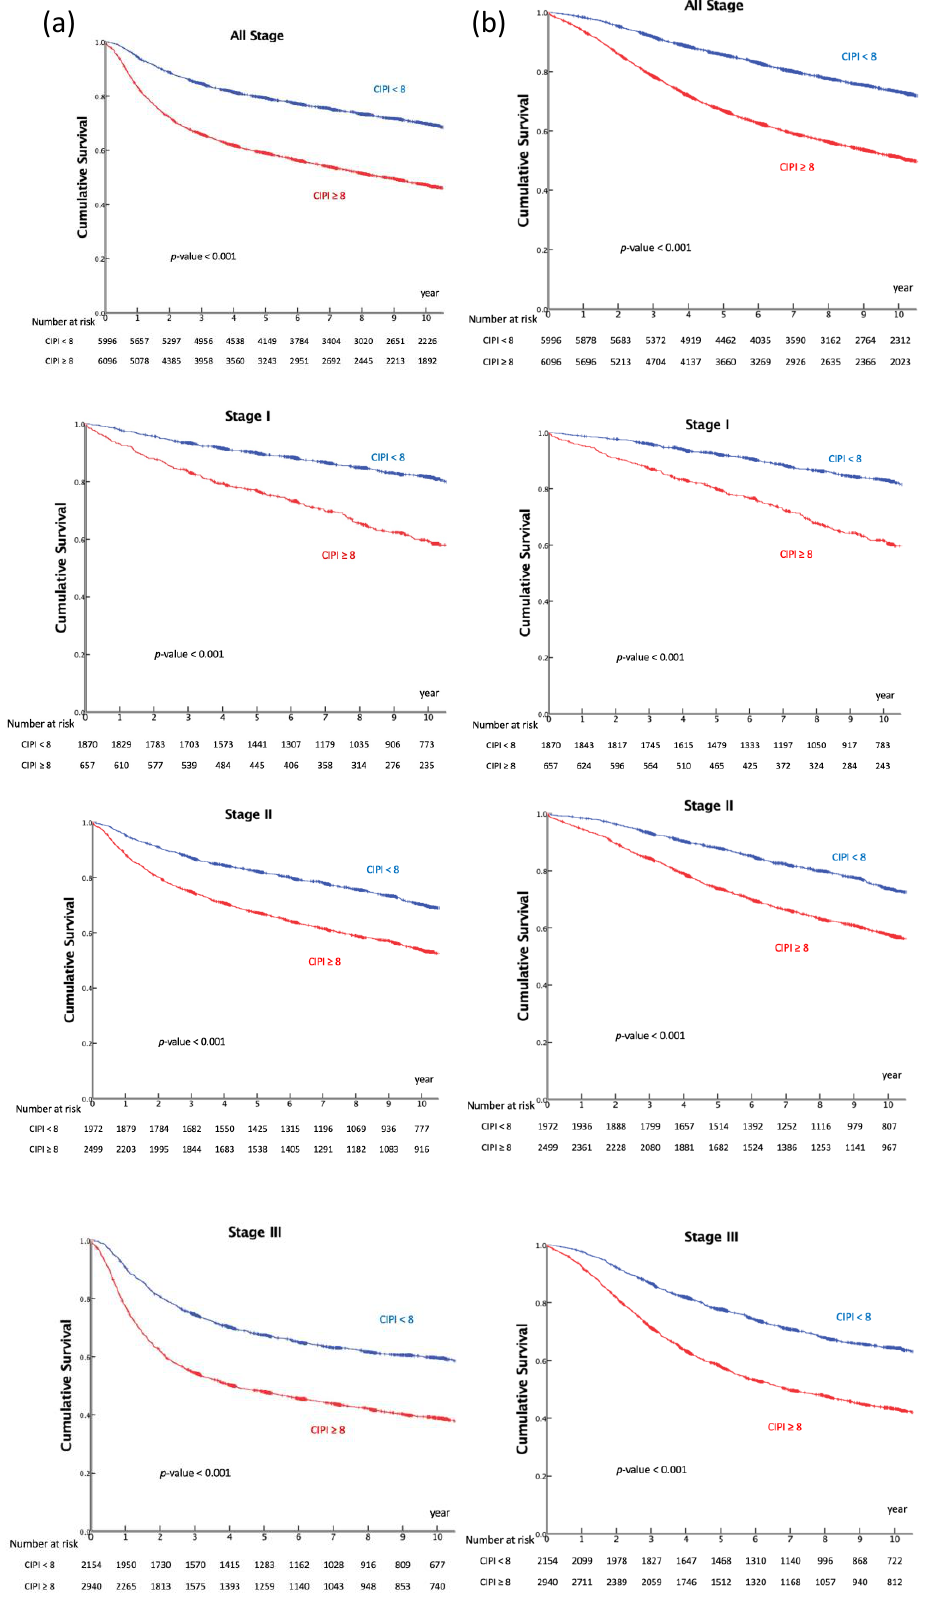
Figure 2. Kaplan–Meier survival analysis for relapse-free survival (RFS) ( a ) and overall survival (OS) ( b ) according to cancer-inflammation prognostic index